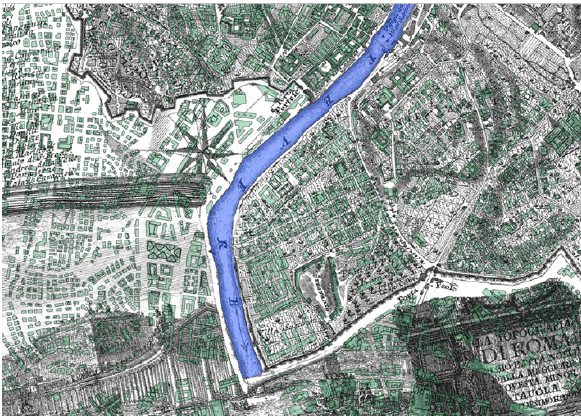
Figure 9. Overlap of the Nolli plan, with the vectorial fabric of the city of Rome extrapolated from the CTR 1: 5000. In the specific the image is a zoom on the Testaccio district.